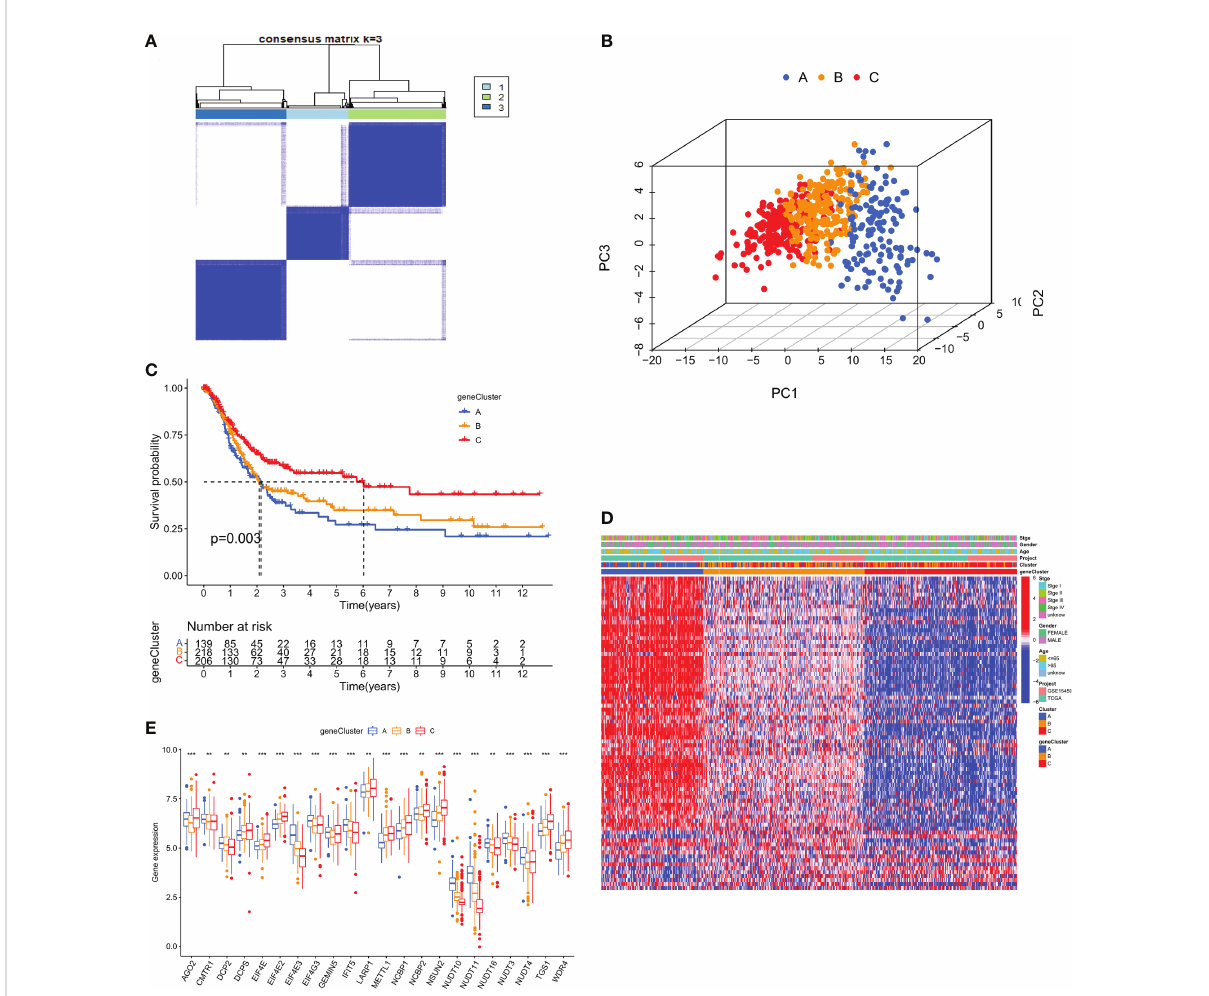
FIGURE 6 (A) ConsensusclusteringmatrixforgenotypingofGCpatients basedon79prognosticDEGs. (B) PCAAnalysisfortestingclusteringeffect. (C) Kaplan-Meier